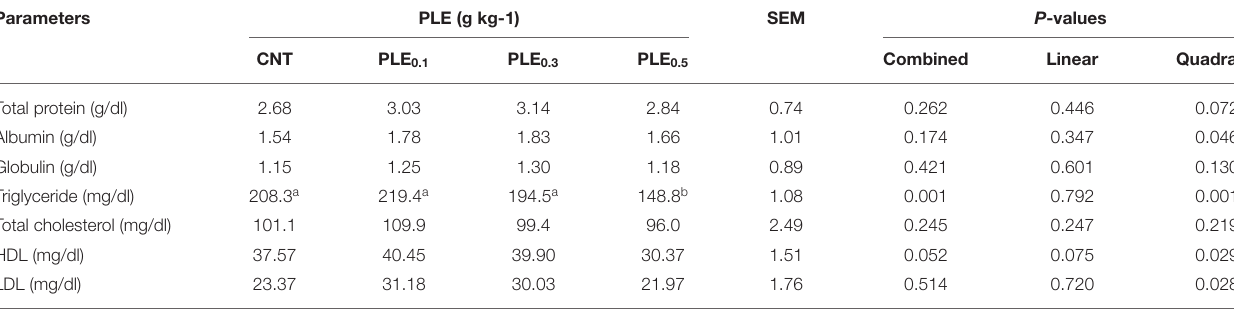
Globulin (g/dl) Total cholesterol (mg/dl)